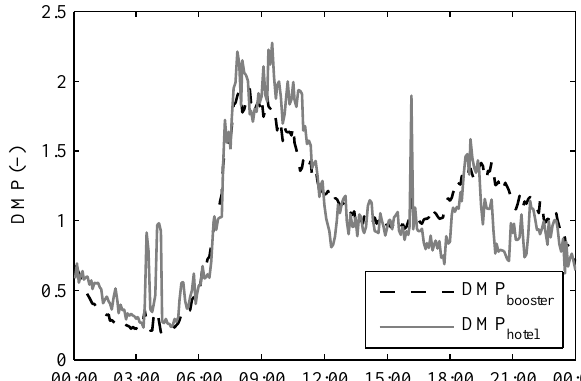
Figure 4. Demand multiplier patterns as used in the Model TD and Model BU , see Table 2. Measured average demand at booster is 23m 3 / h; measured average demand at hotel is 3m 3 /